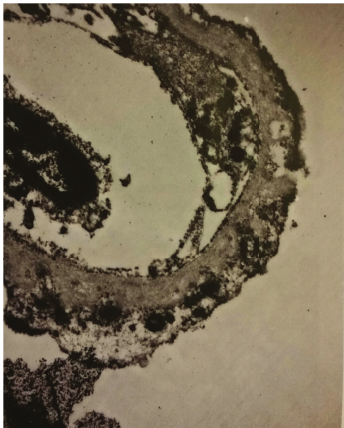
Figure 4: Electron microscopy with global thickening of the glom- erular basement